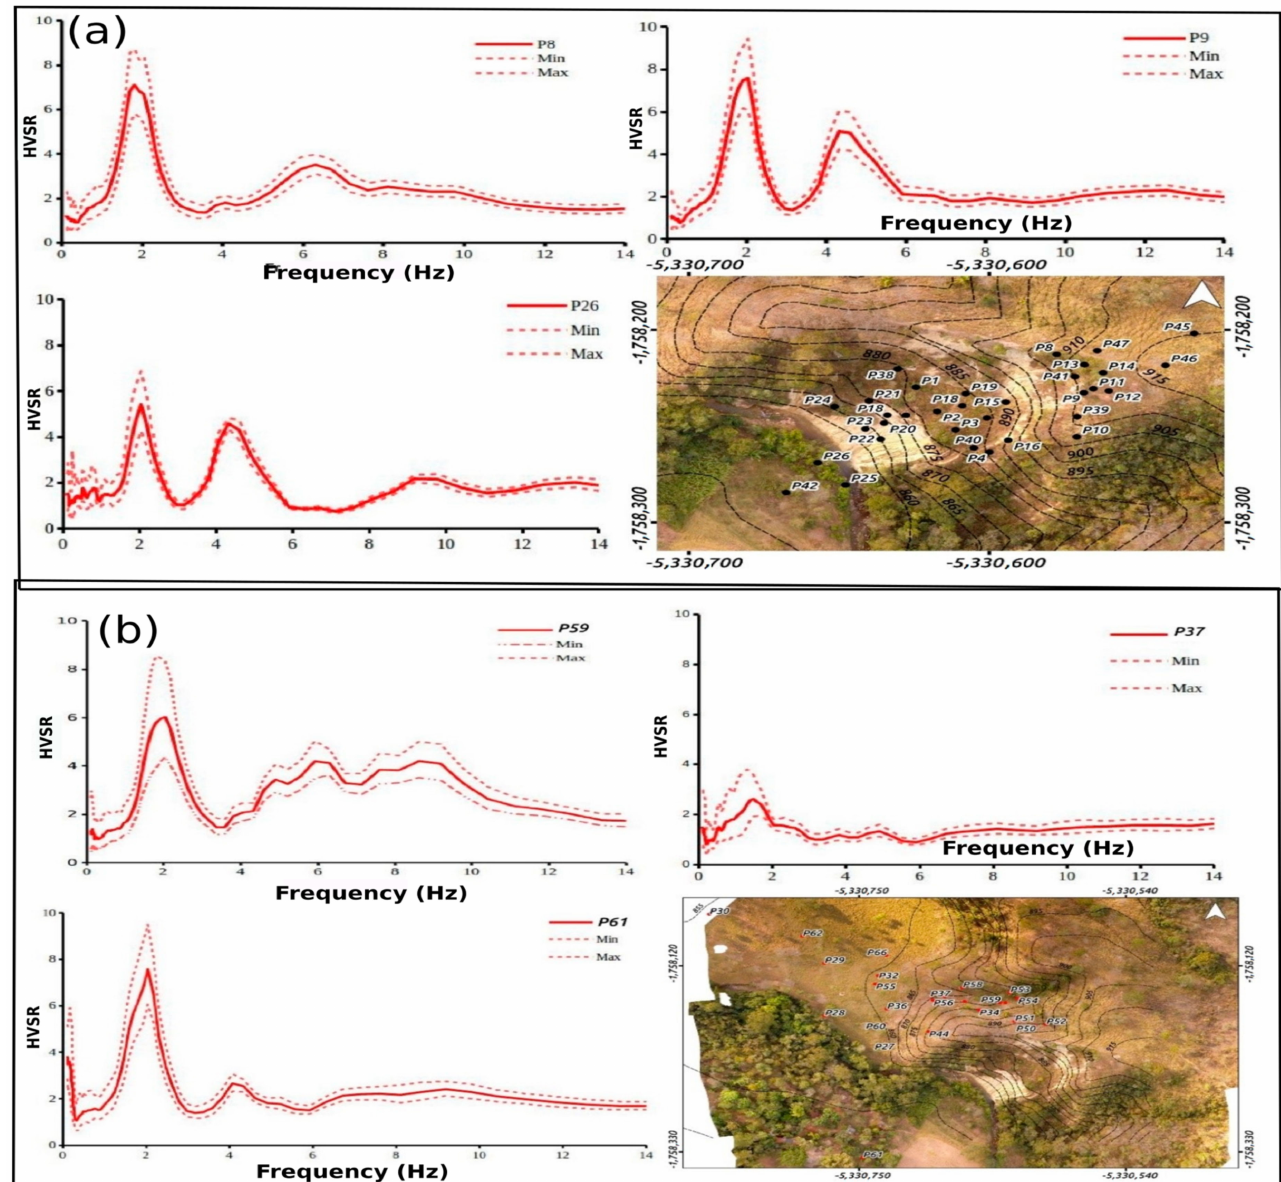
Figure 5. Sobradinho LS geometry using HVSR, a high-frequency peak emerged at LS mass ( a ) which disappeared outside the LS ( b ) (adopted after permission from ref.